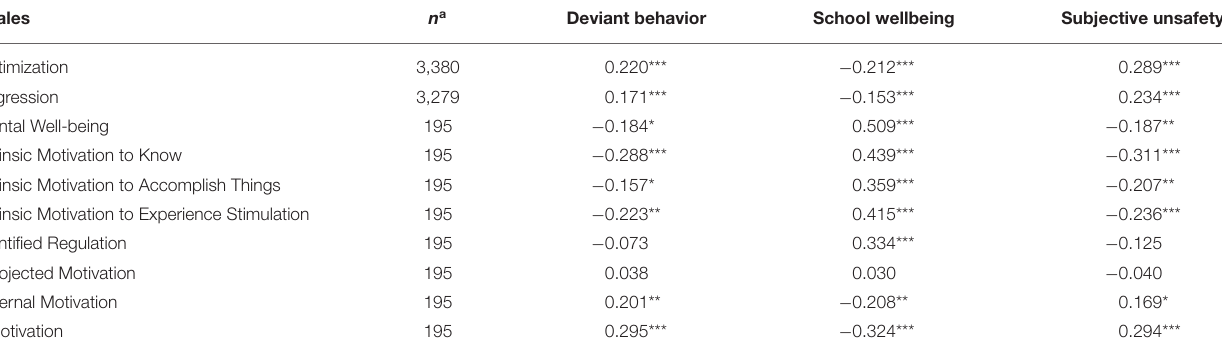
TABLE 3 | Correlations (Pearson’s r ) between three scales of SCQ and the measures of victimization, aggression, mental wellbeing, and types of academic motivation. Scales n a Deviant behavior